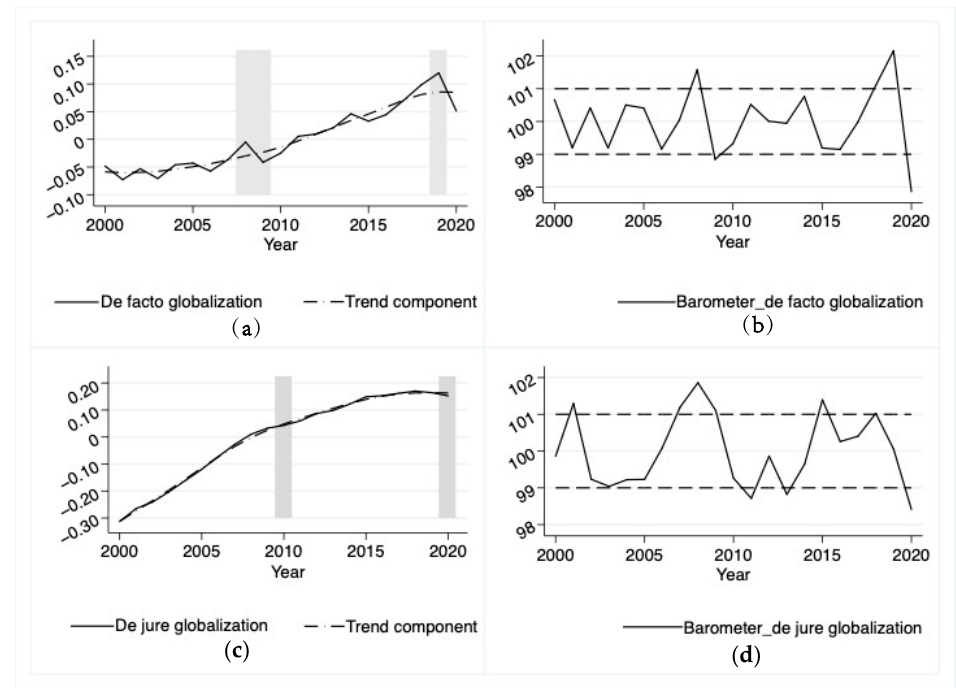
Figure 2. Barometers and trend terms of de facto and de jure globalization. ( a ) De facto globalization trend term. ( b ) De facto globalization barometer. ( c ) De jure globalization trend term. ( d ) De jure globalization barometer.